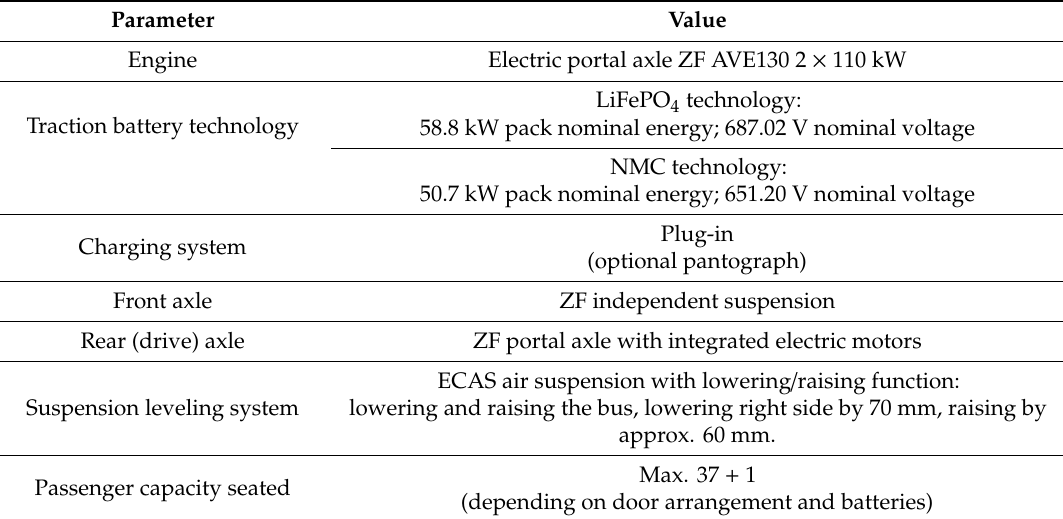
Figure 2. Overall dimensions of the Solaris 12 E bus. ( a ) side view ( b ) front view. Table 1. Main technical data of the Solaris 12 E